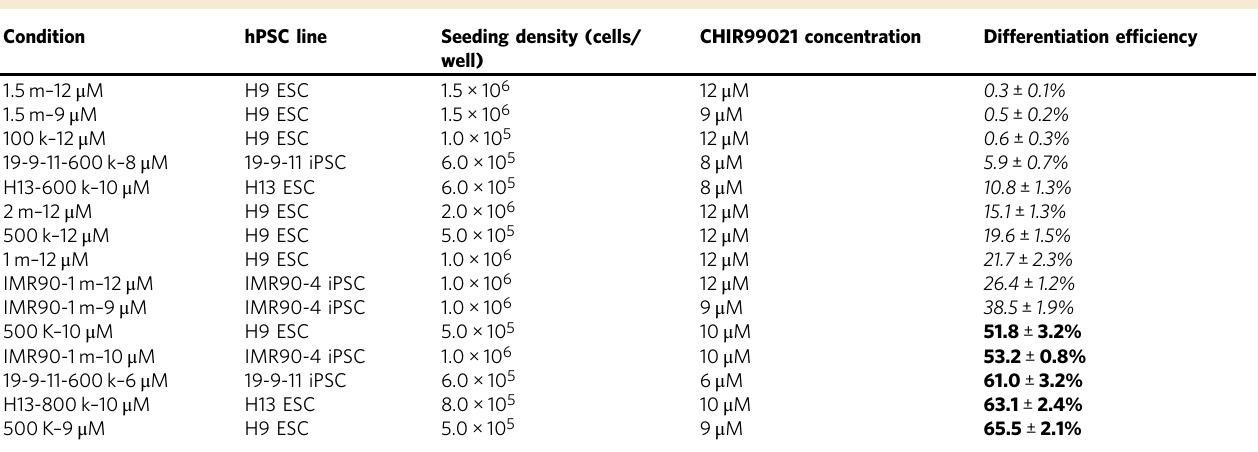
Table 1 Summary of the 15 differentiation